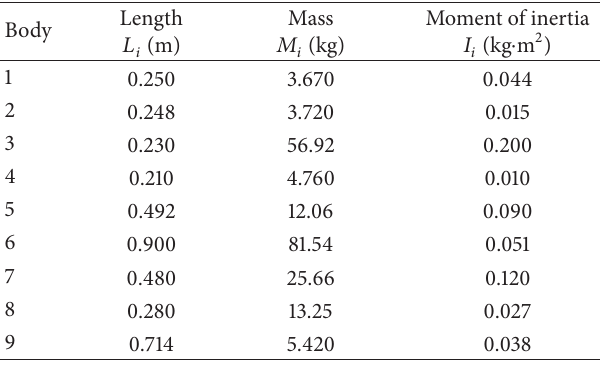
Table 1: Parameters of the components in the mechanism.